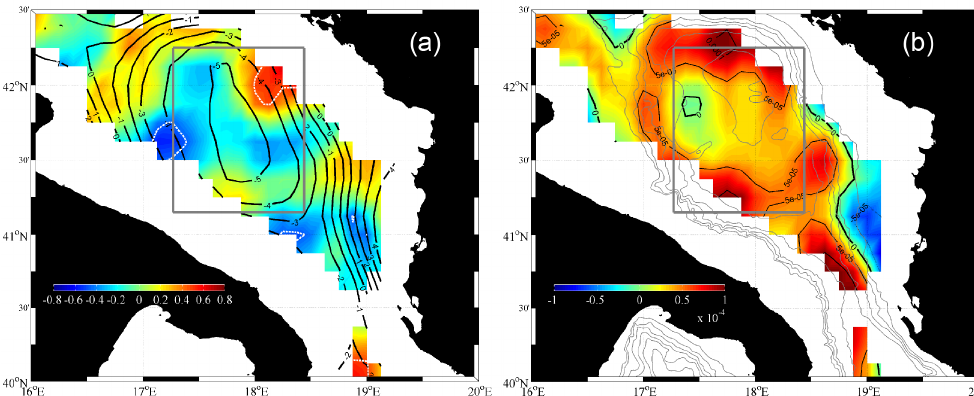
Figure 3. Spatial distribution of the correlation coefficient between the JFM time derivative of the vorticity and the wind-stress curl for the period 1993–2011 (colours). Black bold contours outline the 20-year average of the JFM sea level height (cm), and the white dotted lines indicate the level of the 95% significance (a) ; spatial distribution of the average of the JFM geostrophic current vorticity (colours and the black lines). The grey contours indicate the isobaths between 200and 1200m with the 200m line space (b) . The grey squares show the areas used to estimate the time series in Fig. 2; altimetry grid points located within 50km from the coast have been